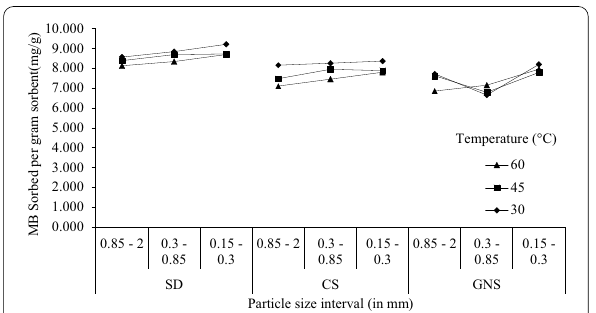
Fig. 5 Sorption of MB on various particle sizes of SD, CS and GNS at 30 °C, 45 °C and 60 °C